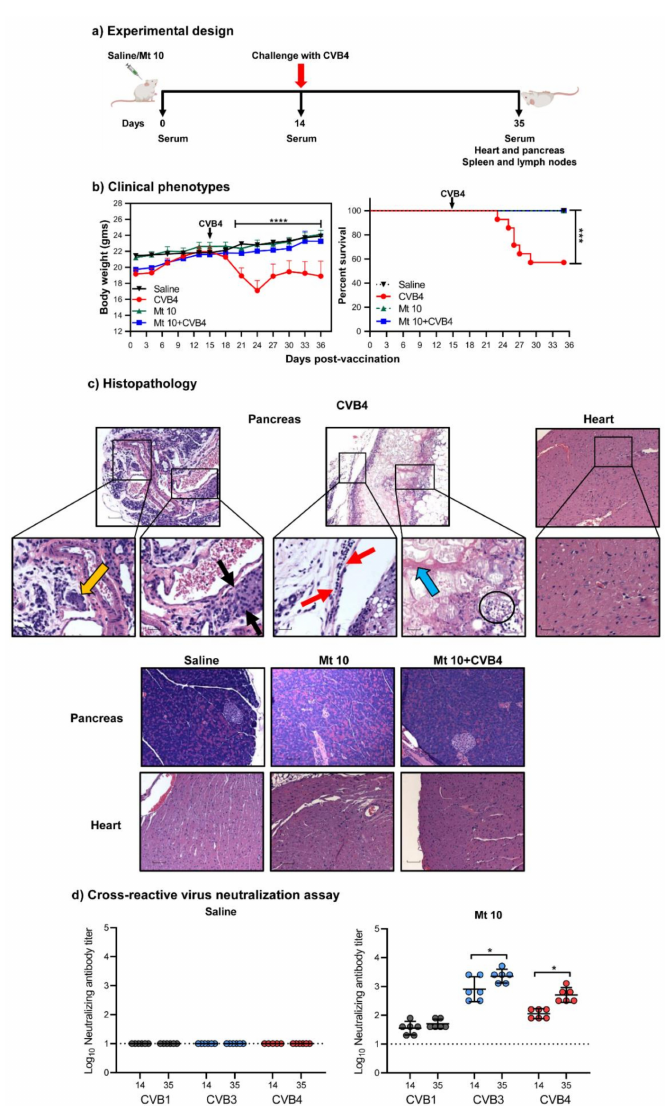
Figure 2. Vaccine virus offers cross-protection against CVB4 infection in challenge studies. ( a ) Experimental design. Two groups of mice each were given saline or vaccinated with the vaccine virus on day 0 after the serum was collected. After 14 days, serum was collected again, and one group from each treatment was challenged with CVB4. Experiments were terminated 21 days post-challenge, and serum and tissues were collected for in vitro experimentation. ( b ) Clinical phenotypes. Body weights (left panel) and survival rates (right panel) of different groups are shown. ( c ) Histopathology. Hearts and pancreata were collected from the indicated groups and processed by H and E staining to evaluate for any inflammatory changes. Representative pancreatic and heart sections are shown. Pancreatic sections and their insets from the CVB4 group had a cluster of acinar cells (orange arrow) and showed atrophy (black arrows), lymphocytic infiltrates (red arrow), necrosis (blue arrow), and karyorrhexis debris from necrotic adipocytes (circle), as opposed to normal sections in the saline, vaccine, and vaccine/CVB4-challenged groups. Magnification, 20 × ; scale bars, 20 µ m. Data sets obtained from three individual experiments, each involving n = 3–8 mice, are shown. ( d ) Cross-reactive virus neutralization assay. Sera were collected from saline and vaccine/CVB4-challenged groups on days 14 and 35, and virus neutralization assays were performed on LLC-MK2 (for CVB1) or Vero cell (for CVB3 and CVB4) monolayers. Incubation was continued for four days to calculate the nAB titers based on CPE. Data from n = 6 samples, each representing a pool of sera from 3 to 5 mice, are shown. Two-way ANOVA with a Sidak’s post-test was used to compare body weight changes in the saline, vaccine, and vaccine/challenged groups relative to the CVB4 group; log-rank test with Bonferroni correction was used to compare survival curves. * p ≤ 0.05, *** p ≤ 0.001, and **** p ≤